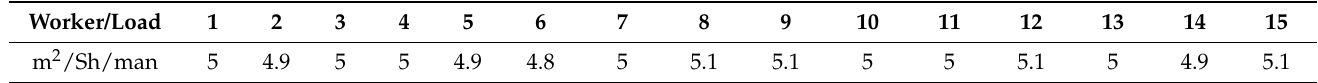
Table 7. Tiling works—performance m 2 /Sh/man.